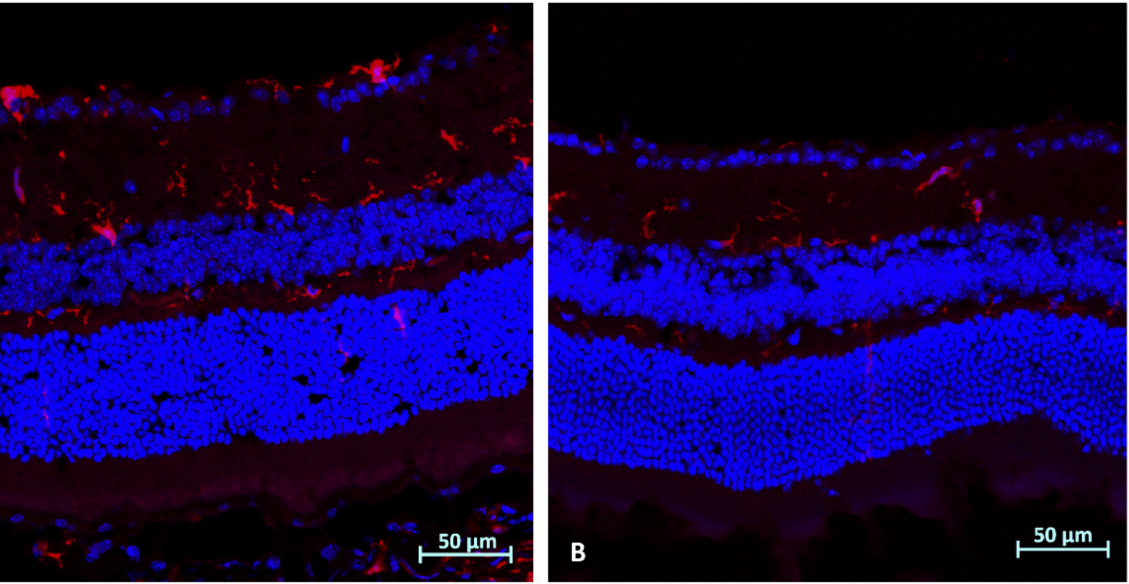
Figure 3. Immunohistochemistry analysis (day 3) for microglial activation (Iba1): ( A ) Right eye of WT mouse following ONC without treatment, showing increased microglial activation, as compared to AZ-treated RE ONC-induced eye ( B ), demonstrating reduced